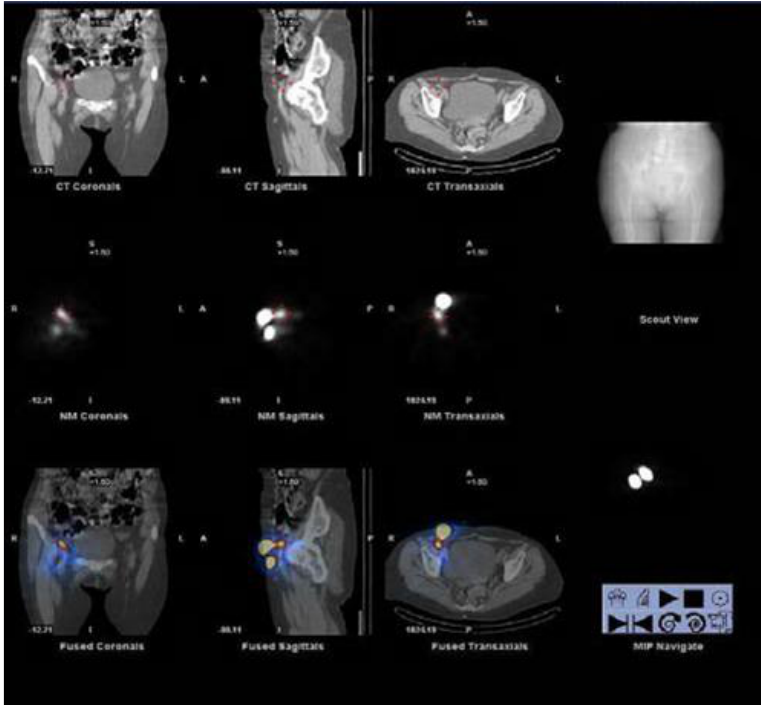
Figure 2. SPECT/CT lymphoscintigraphy of the